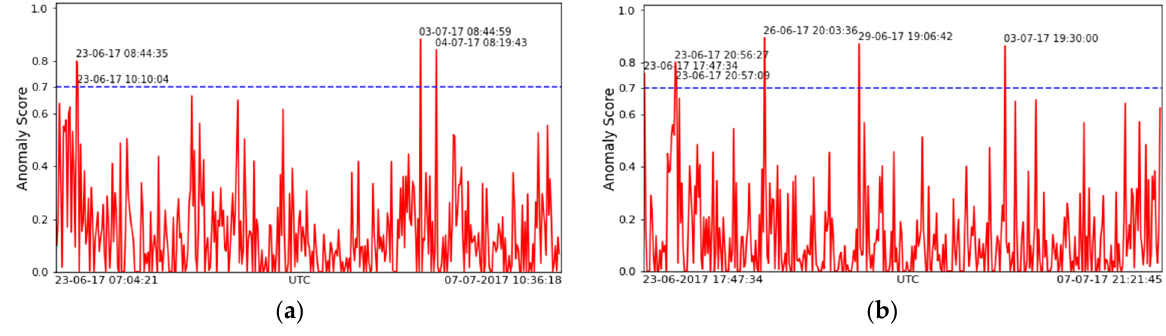
Figure 6. CLOP anomaly score for normal period operation. ( a ) Day-time window observations; ( b ) night-time window observations.